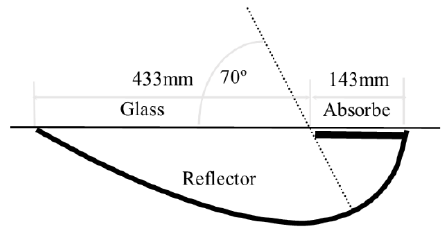
Figure 5. Diagram of east/west MaReCo with 70° optical axis from the cover glass [23].